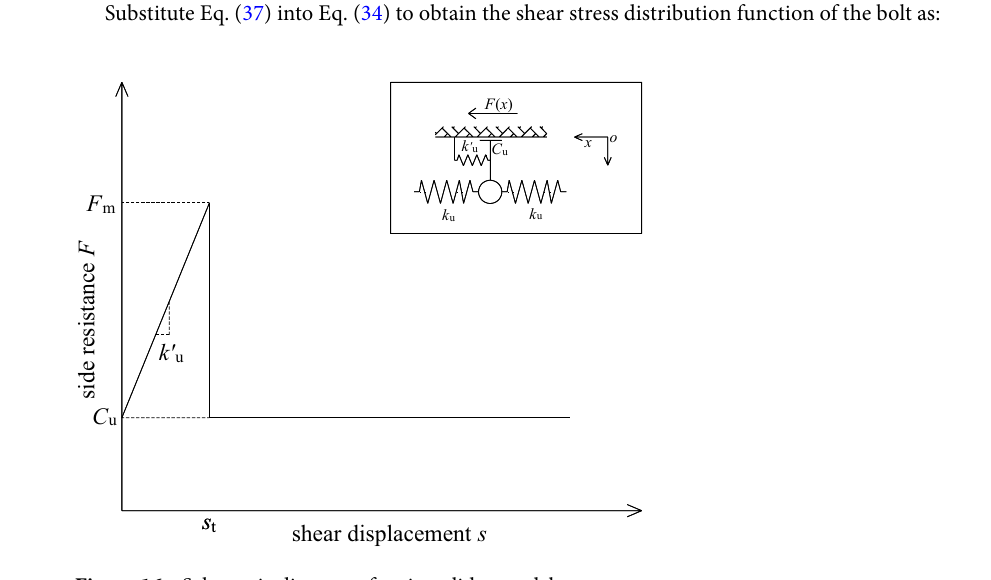
Figure 16. Schematic diagram of spring-slider